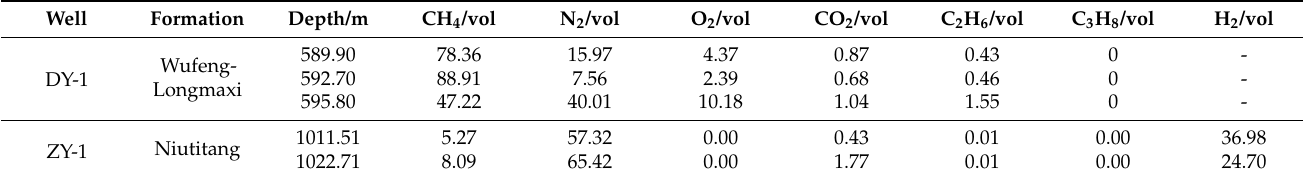
Table 8. Gas components of the Wufeng-Longmaxi and Niutitang Formations in northern Guizhou